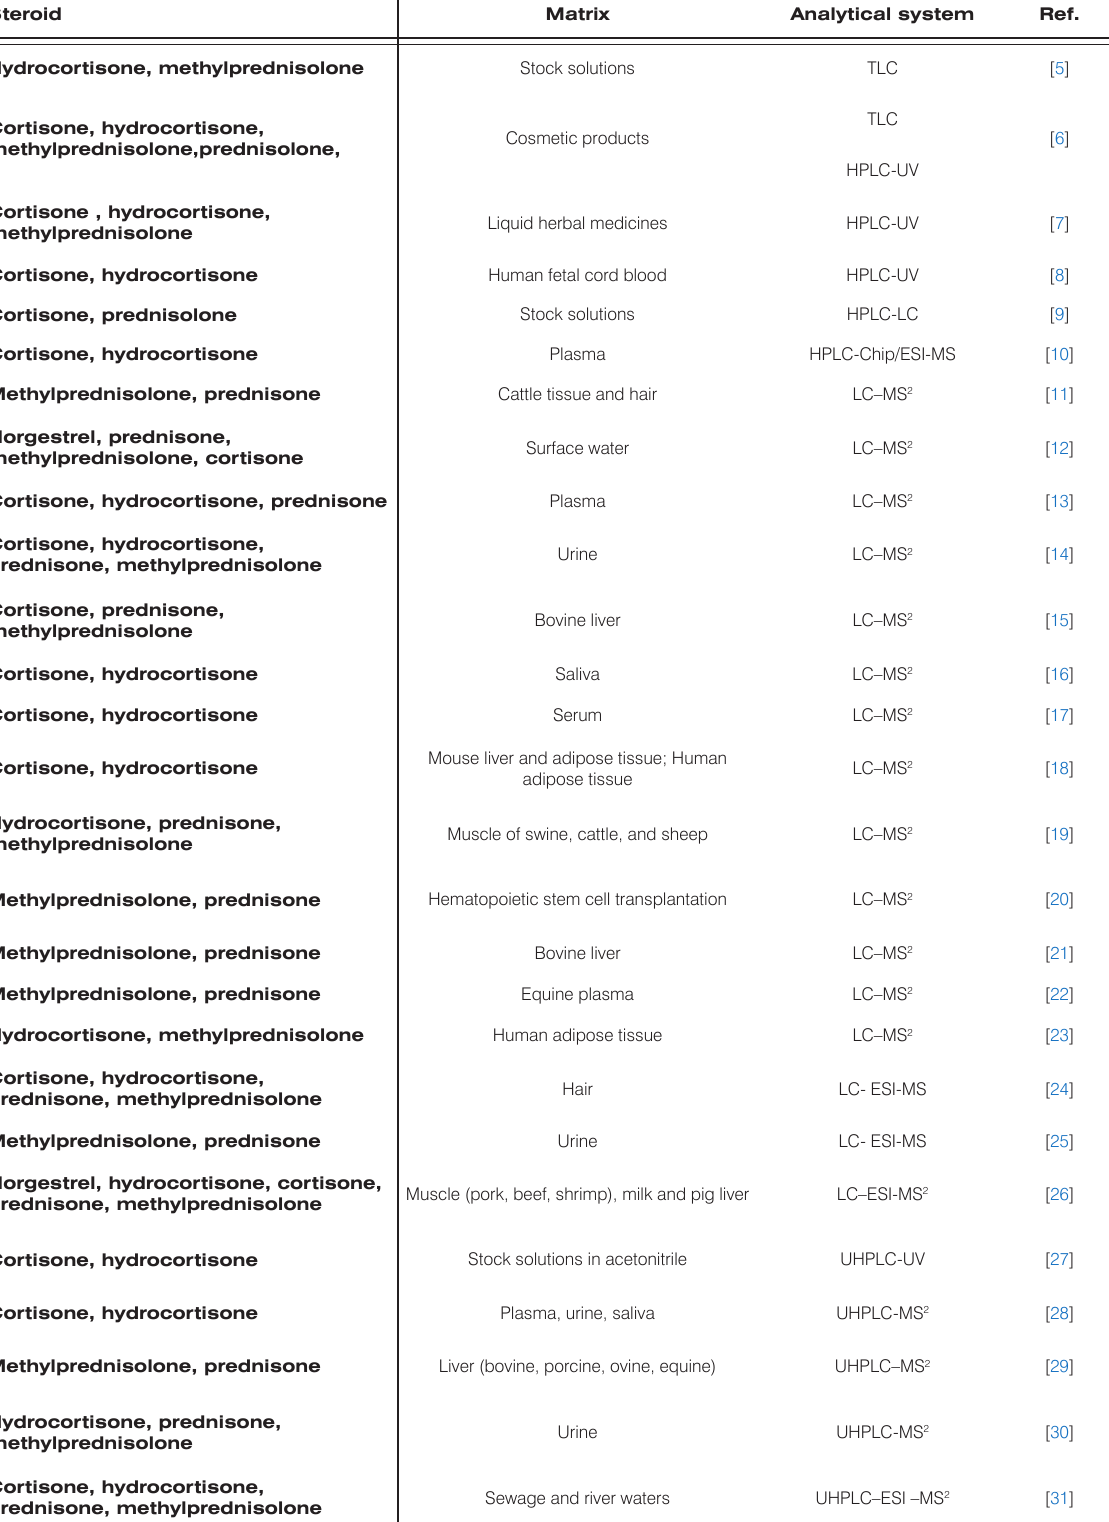
Table 1. Determination of steroids in different